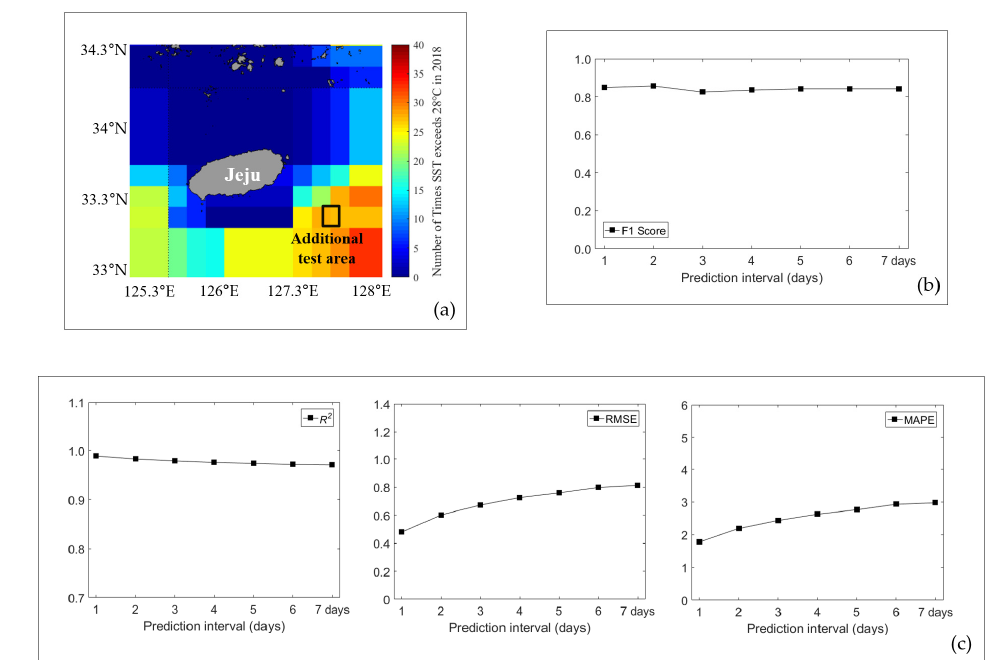
Figure A2. HWT and SST prediction performance for additional test area using multi dataset. ( a ) Area selected for further experiments. ( b ) F1 score values for additional test area. ( c ) R 2 , RMSE , and MAPE values for the additional test area.